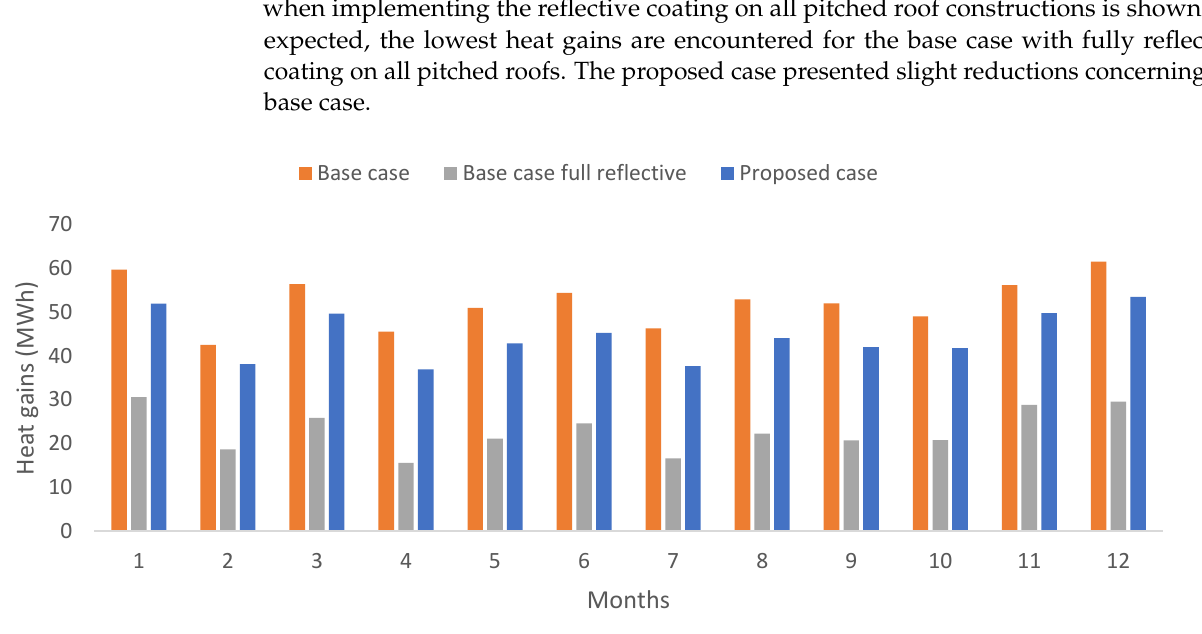
Figure 13. Comparison of monthly roof-ceiling heat gains for the urban zone, during occupied hours. Own elaboration.